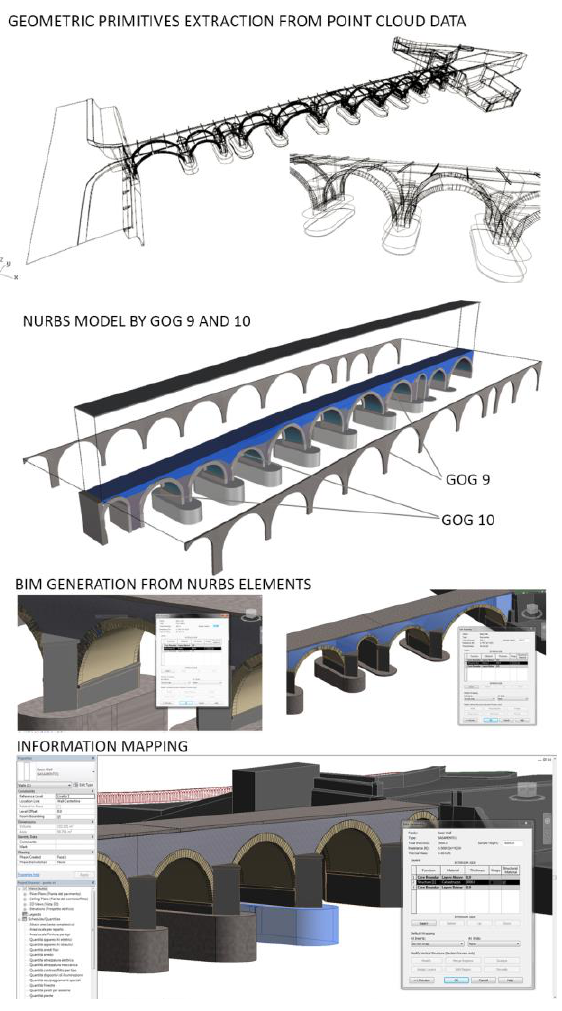
Figure 6. Azzone Visconti bridge's BIM generative process.